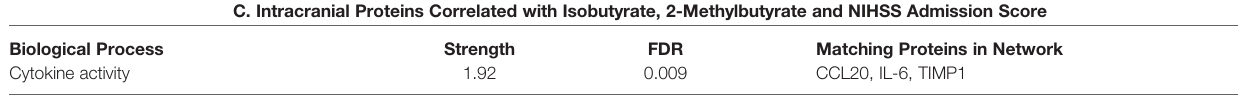
FDR, False Discovery